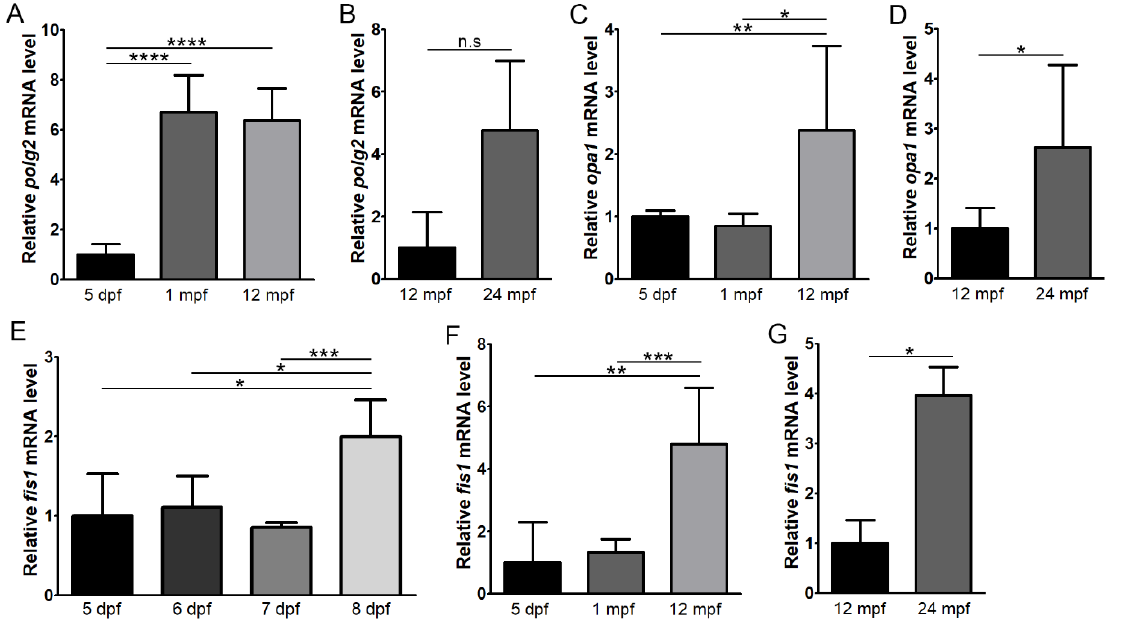
Figure 6. Expression levels of polg2 , opa1 and fis1 with age in the zebrafish retina. RT-qPCR was performed to assess expression of polg2 ( A , B ), opa1 ( C , D ) and fis1 ( E – G ) at 5 days post-fertilisation (dpf), 1 month post-fertilisation (mpf), 12 mpf and 24 mpf (n = 5). Expression of fis1 was also assessed at 5 – 8 dpf (n = 4) ( E ). * p < 0.05; ** p < 0.01; *** p < 0.001; **** p < 0.0001; n.s, not significant.